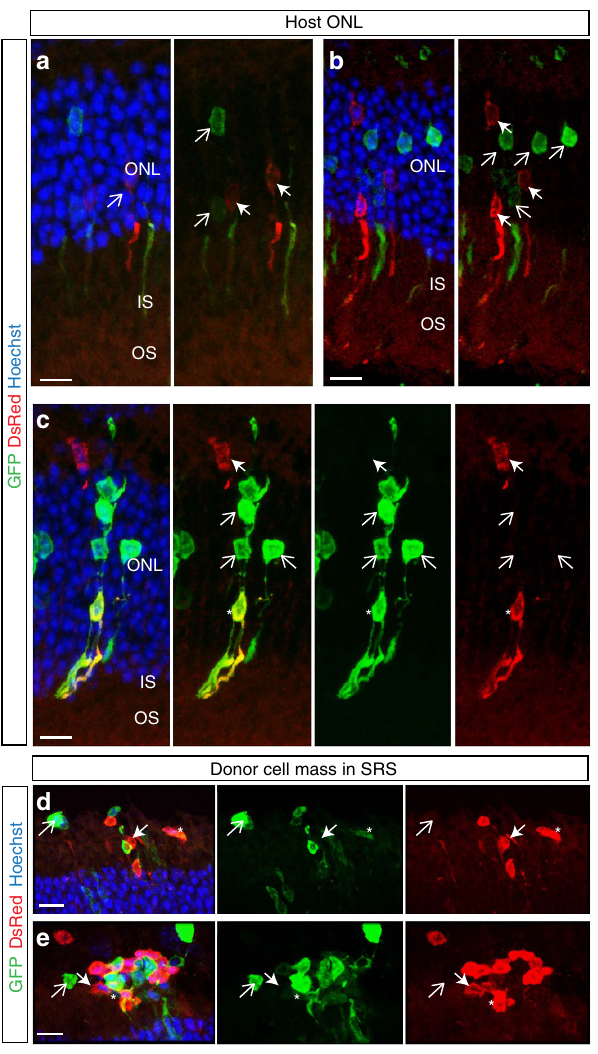
Figure 7 | Material transfer involves interaction between donor and host photoreceptors NrlGFP þ /CD73 þ ( green ) and DsRed þ /CD73 þ ( red ) donor cells were transplanted into adult wild-type and Gnat1 (cid:2) / (cid:2) recipients. ( a – c ), confocal projection images showing heterogeneous mixes of DsRed þ ( closed arrow ) and GFP þ ( open arrow ) cells within the host ONL. Occasionally, a photoreceptor within the host ONL bore both GFP and DsRed labels ( asterisk ). Nuclei are labelled with Hoechst ( blue ). ( d , e ), confocal projection images showing a similar finding for donor cells in the SRS. The majority expressed either GFP ( open arrow ) or DsRed ( closed arrow ), but some expressed both reporters ( asterisk ). For all panels, images from left to right show individual and/or combined channels for the same region of interest. Scale bars 10 m m.